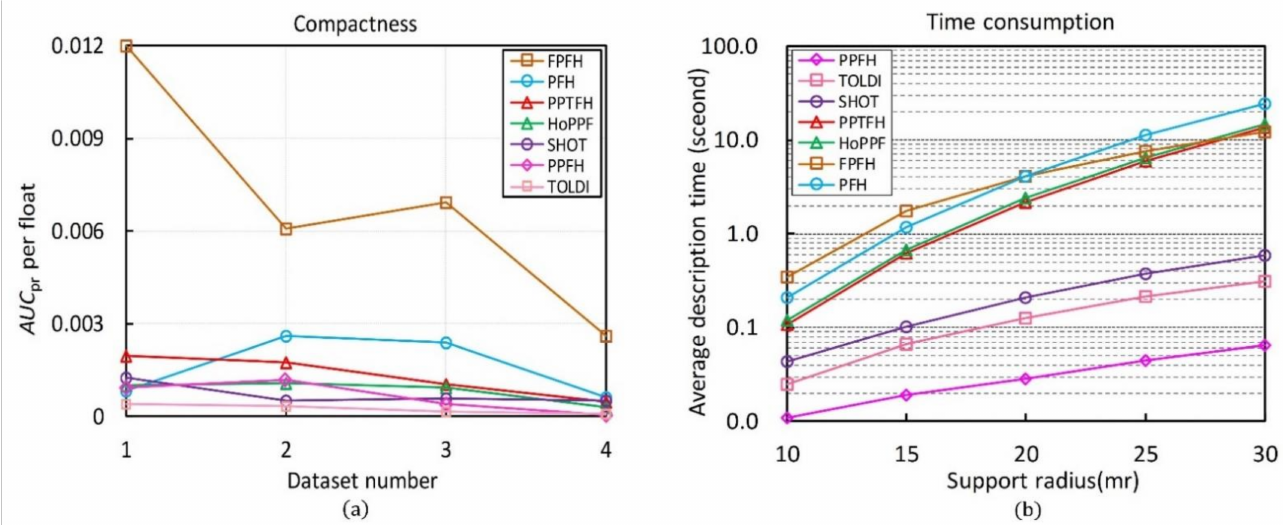
Figure 9. Evaluation results of compactness and time efficiency. ( a ) Compactness of all compared methods. ( b ) Time consumption of all compared methods, and the y axis is shown logarithmically for